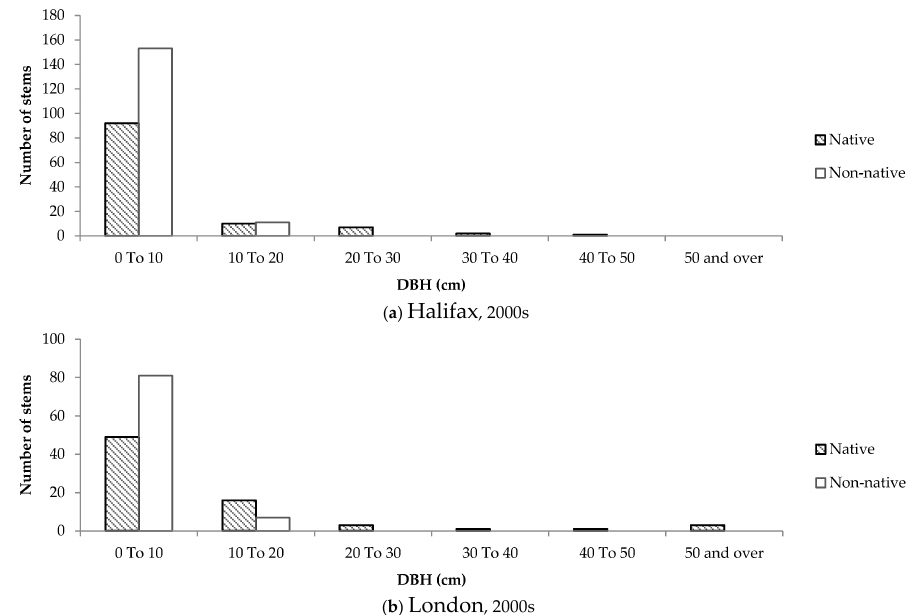
Figure 9. Size-class distribution of native and non-native trees on residential properties in neighbourhoods developed in the 2000s in: ( a ) Halifax; ( b ) London. Trees with a DBH = 10 cm, 20 cm, etc. are included in the lower histogram bin.